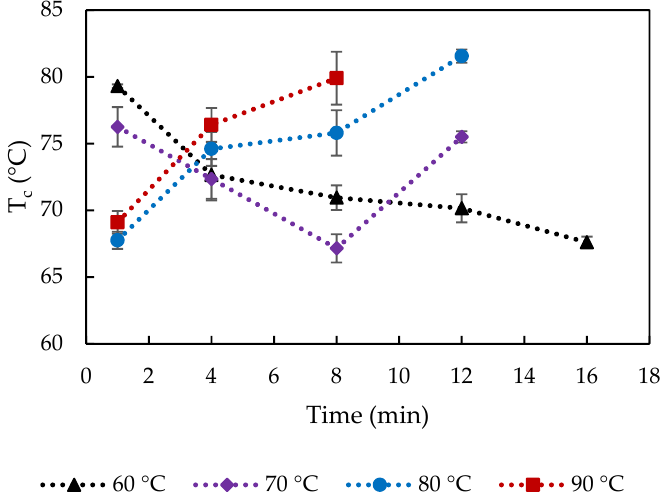
Figure 9. Crossover temperature (T c ) of curd cooked at varied cooking conditions. The error bars indicate standard deviations.